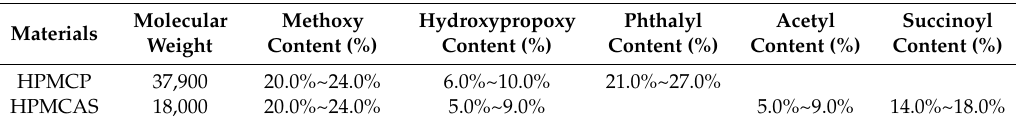
Table 1. The compositions list of hydroxypropyl methylcellulose phthalate (HPMCP) and